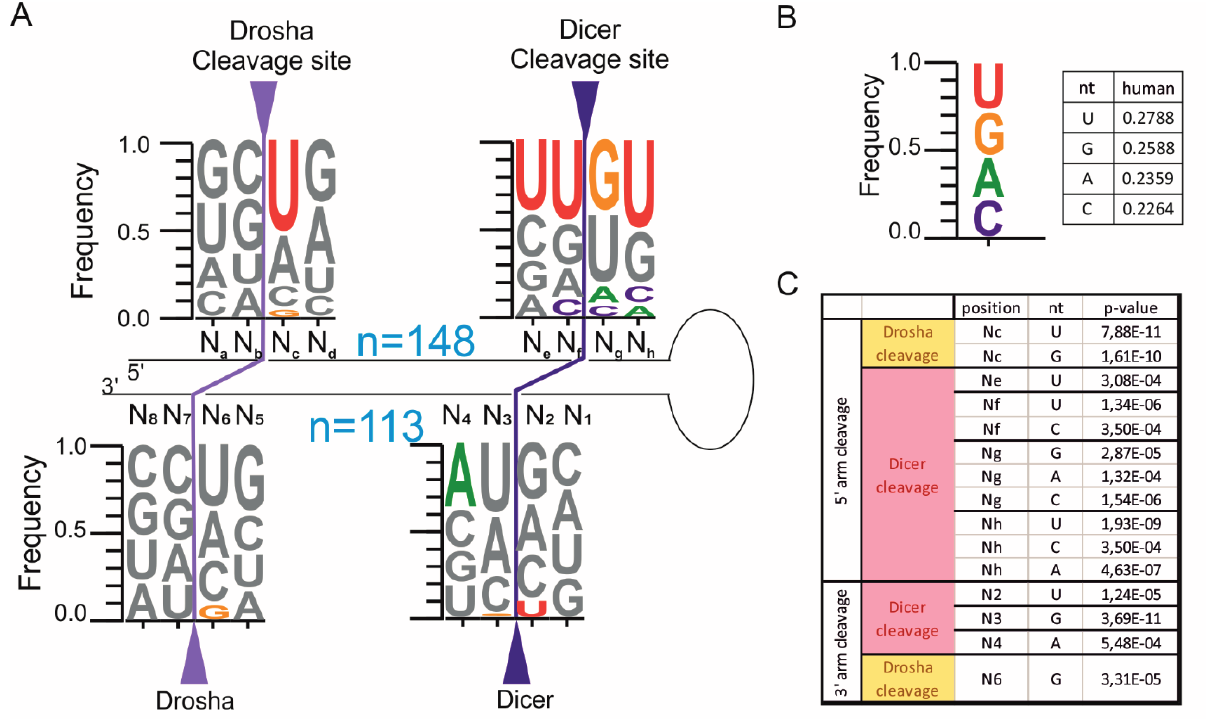
Figure 1. The nucleotide frequencies at hairpin positions adjacent to the Drosha cleavage site (N a , N b , N c , N d , N 5 , N 6 , N 7 , and N 8 ) and the Dicer cleavage site (N e , N f , N g , N h , N 1 , N 2 , N 3 , and N 4 ) in the most abundant miRNA variant is presented as a WebLogo sequence. ( A ) For each sequence logo, the y-axis denotes the frequency of that position being a specific nucleotide, with the size of the nucleotide correlating to its frequency. The nucleotides that are significantly different from the background are marked with solid-color letters ( p < 0.00078, two-sided Fisher’s exact test with Bonferroni correction), and the p -values are provided in Figure 1C. The letter n denotes the number of analyzed miRNAs; ( B ) The background was defined as the average frequencies of nucleotides that were identified for the human pri-miRNA sequences that were deposited in miRBase ver. 14 (the excluded miRNAs are described in the Experimental Section). The fraction of each nucleotide is presented on the right; ( C ) p -value for the statistically significant differences that were observed between total miRNA population vs. background. Positions are designated as in ( A